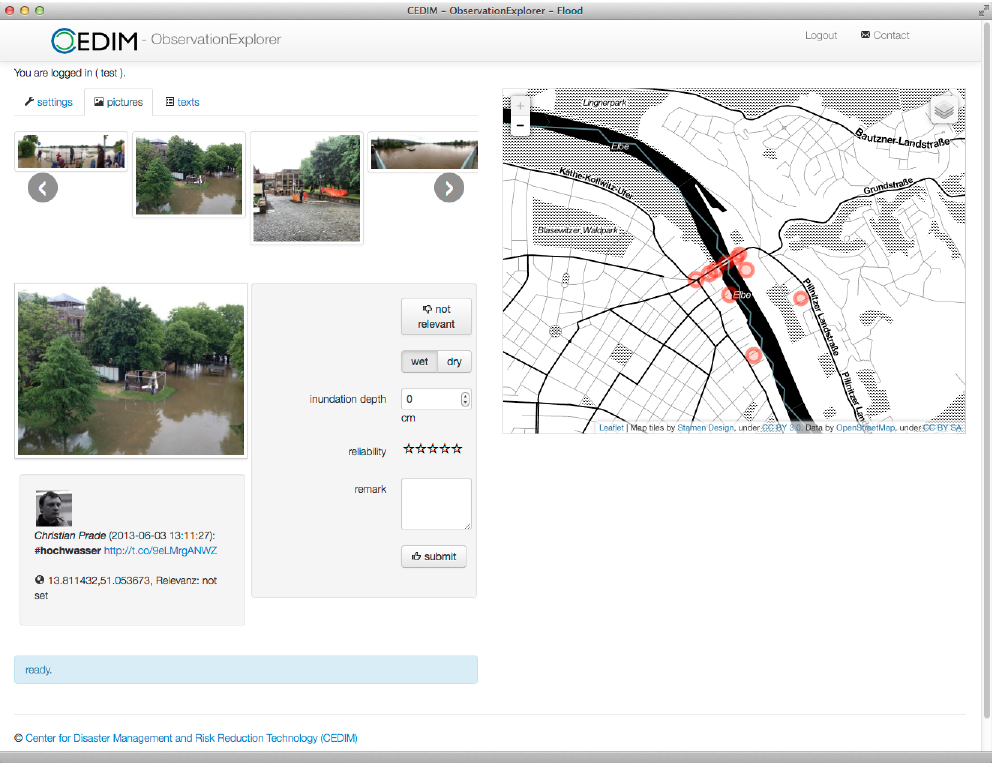
Figure 2. PostExplorer: media view and map view (map tiles by Stamen Design), under a Creative Commons Attribution (CC BY 3.0) license. Data by OpenStreetMap, under an Open Data Commons Open Database license